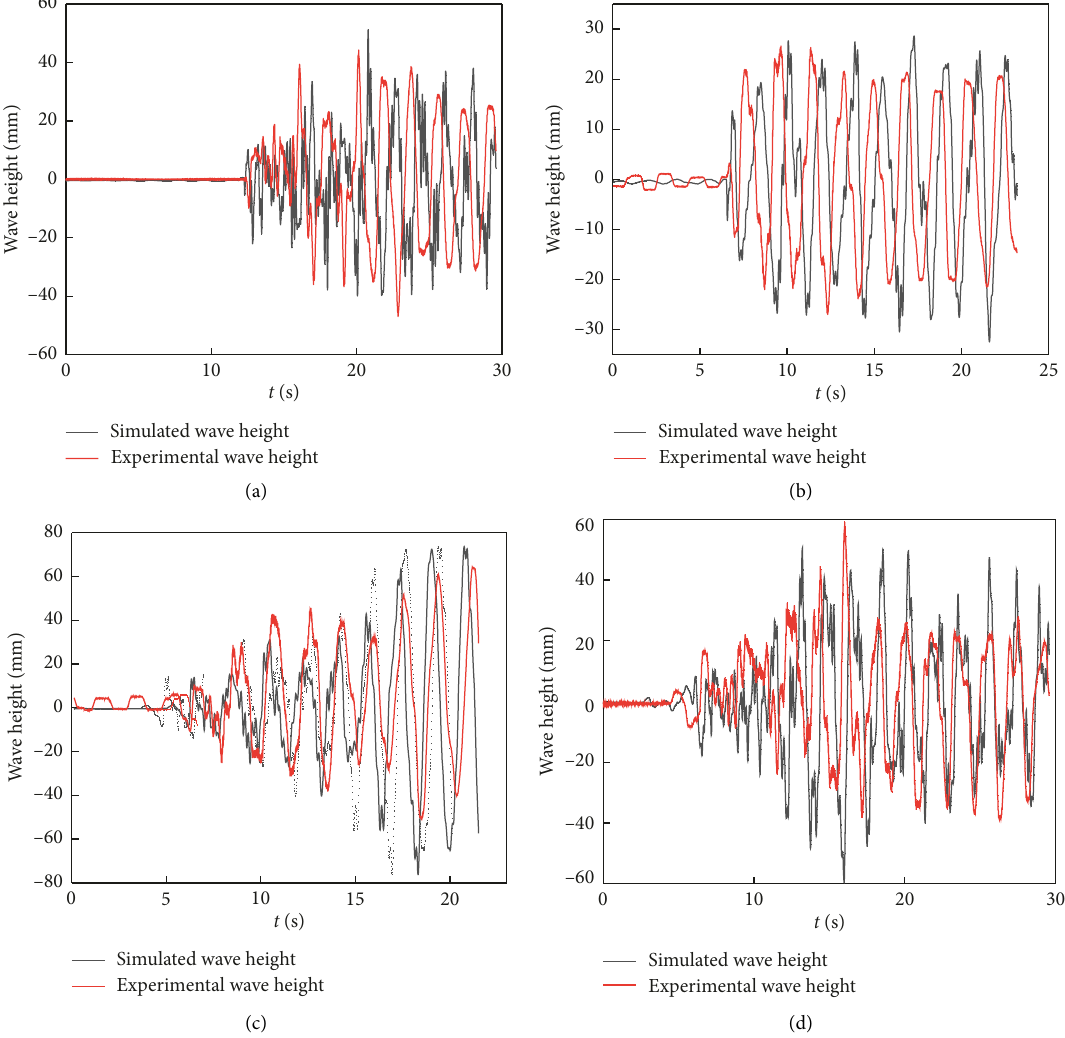
Figure 6: Comparison of simulated wave-height and test wave-height time history curves. (a) EL-Centro time history curve of the wave. (b) JM time history curve of the wave. (c) Taft time history curve of the wave. (d) Pasadena time history curve of the wave. Note . When the duration time of ground motion stopped, the storage fluid will turn into free vibration. The damping ratio of the storage fluid is 0.005. So there will be a attenuation trend after the shaking wave height of the storage fluid in the